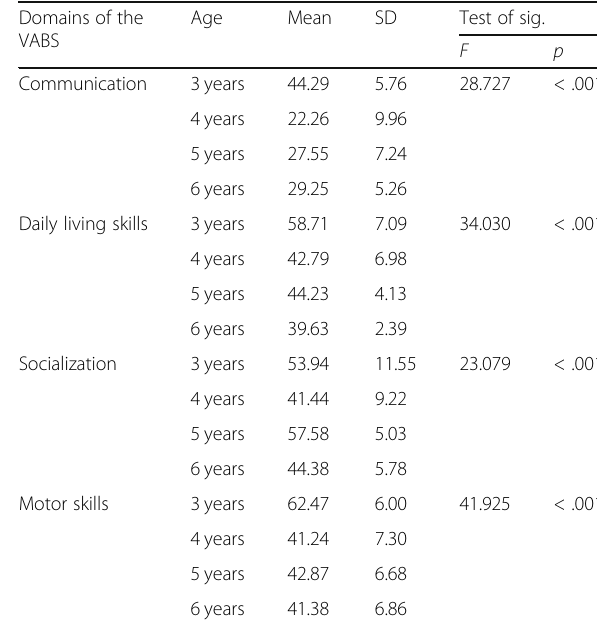
Table 2 Age difference in relation to domains of adaptive